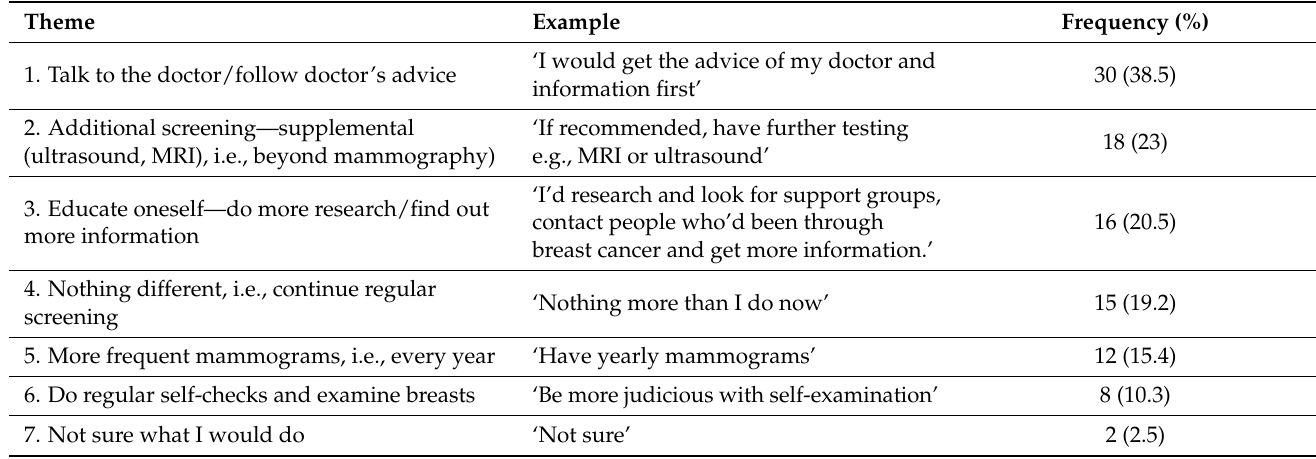
Table 3. Main themes and sub-themes for women’s intentions following hypothetical BD notification with quotations and frequencies ( n = 78)